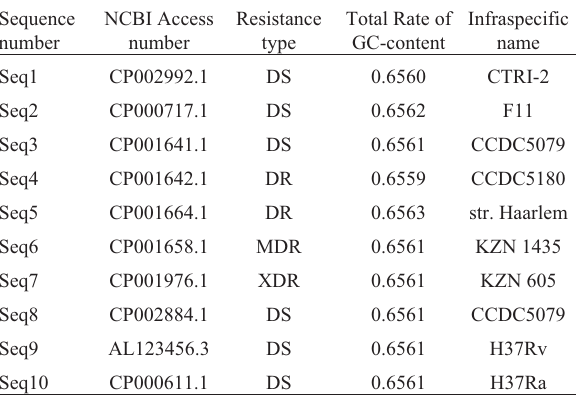
Table 2 - Description of the Mycobacterium tuberculosis